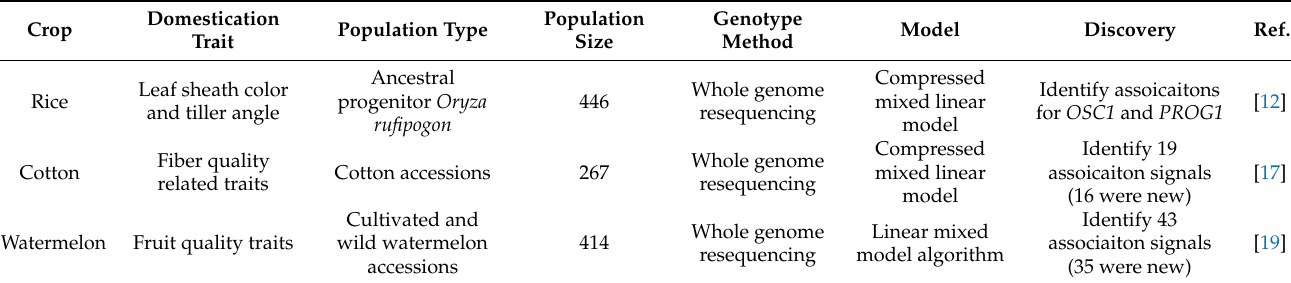
Table 2. The application of GWAS to crop